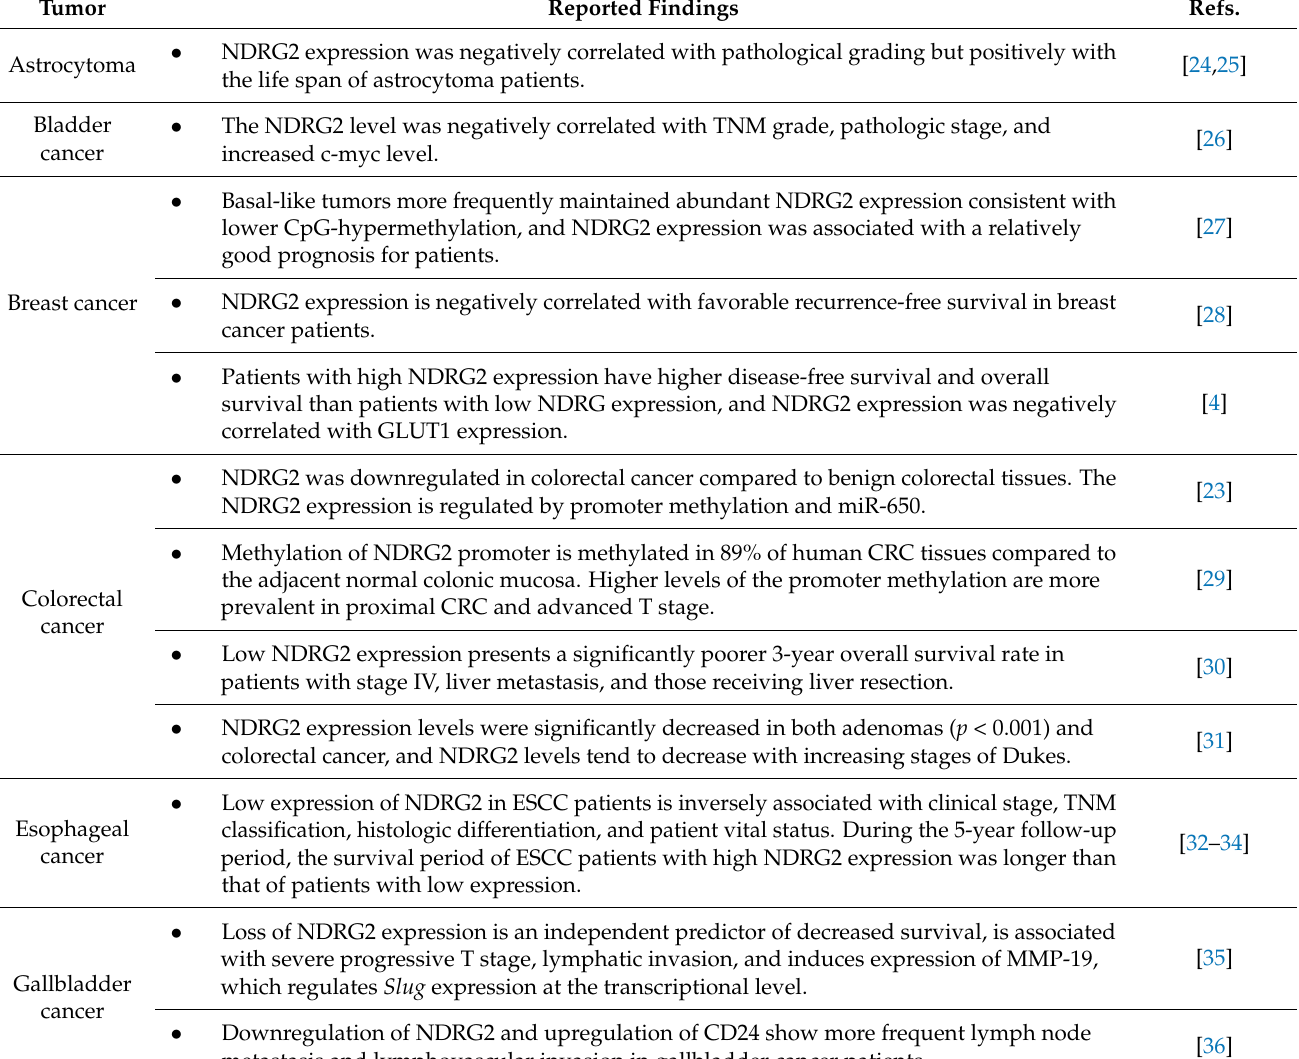
Table 1. Clinicopathological role of NDRG2 in